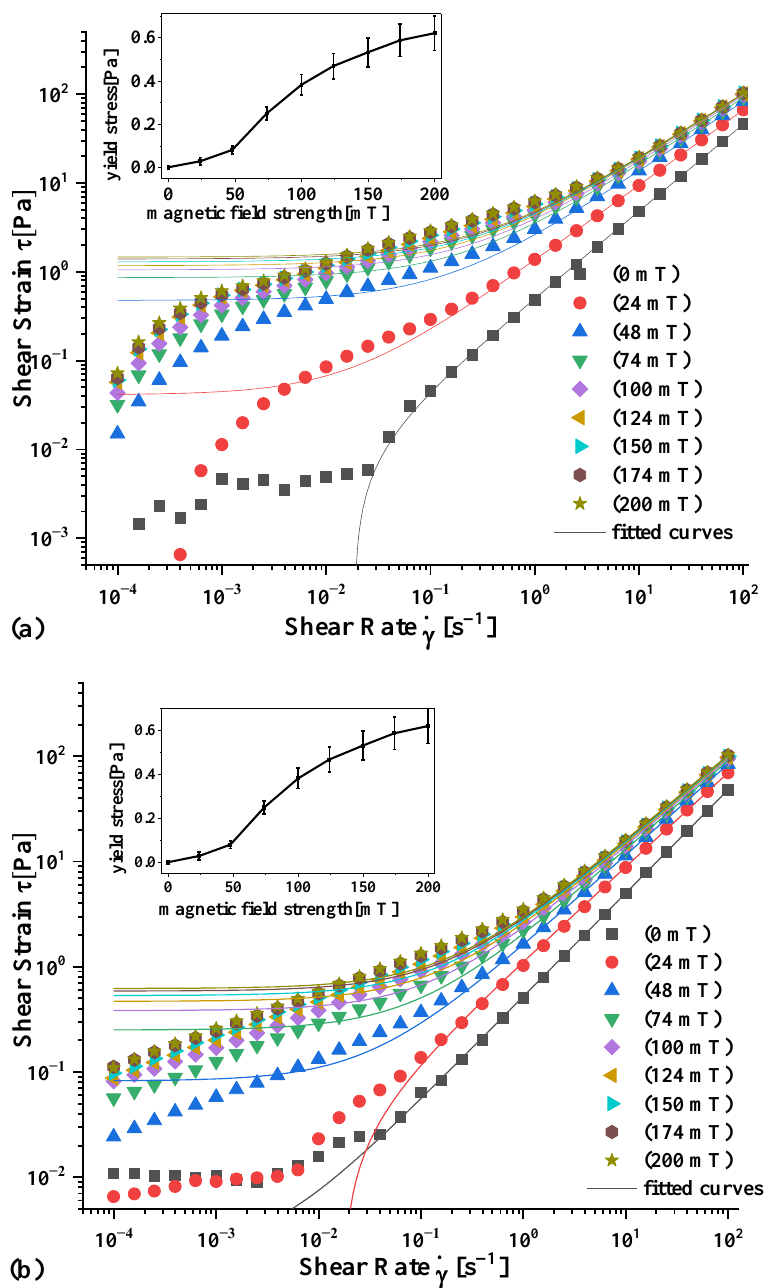
Figure 3. Static and dynamic flow curves and yield stresses of FFs under different magnetic field strengths: ( a ) Scanning shear rate from low to high; ( b ) Shear rate from high to low scanning. It can be seen from the experimental results that different magnetic field strength corresponds to different flow curves, and shear stress increases with the increase of magnetic field strength. The flow curve changes significantly between 0 mT and 48 mT, and the